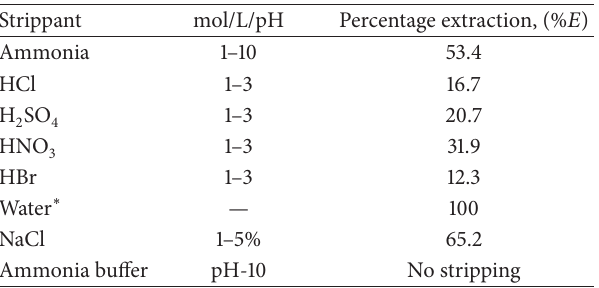
Table 2: Extraction behavior of platinum(IV) as a function of stripping agents. (Pt(IV) = 150 𝜇 g, Aq: Org = 2.5 :1, pH = 0.50, ascorbic acid = 0.01M, equilibrium time = 3 min, and n-octylaniline = 0.1M in